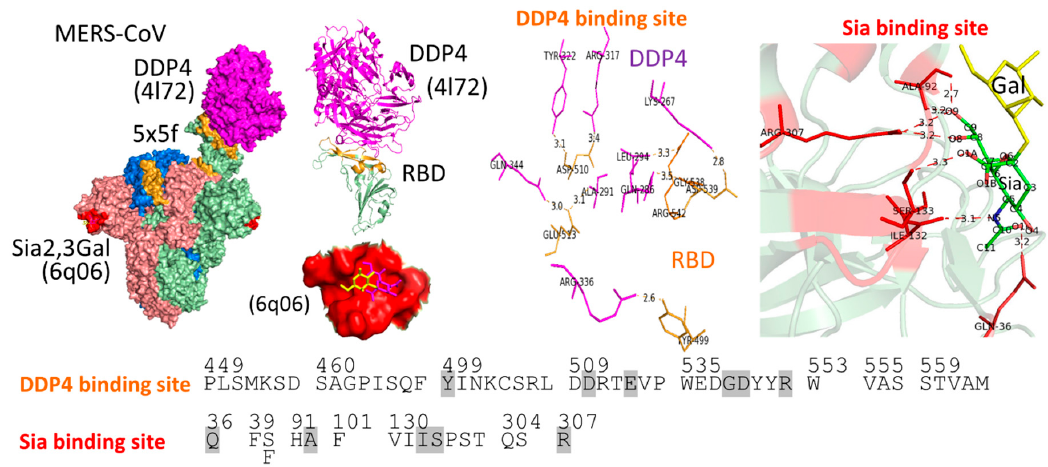
Figure 9. Binding of MERS-CoV S1-CTD to human DDP4 receptor (pdb: 4l72) and S1-NTD to Sia α 2,3Gal receptor (pdb: 6q06). Middle: Cartoon diagram of MERS-CoV S1-CTD (pale green) in complex with human DDP4 (magenta) and surface diagram (red) of MERS-CoV S1-NTD in complex with Sia α 2,3Gal receptor (Sia in magenta stick and Gal in yellow stick). Amino acids in the bright orange area of S1-CTD and in the red area of S1-NTD being a DDP4 binding site and a Sia binding site, respectively, are shown in the lower panel. Right: Direct interactions between amino acids of the DDP4 binding site and those of the DDP4 receptor and between amino acids of the Sia binding site and those of a Sia α 2,3Gal receptor. The bond distance in angstroms of each direct interaction is shown on the dash lines. Amino acids involved in indirect interactions are highlighted in gray in the lower panel. 4l72, 6q06 and 5x5f are from [251], [148] and [205],